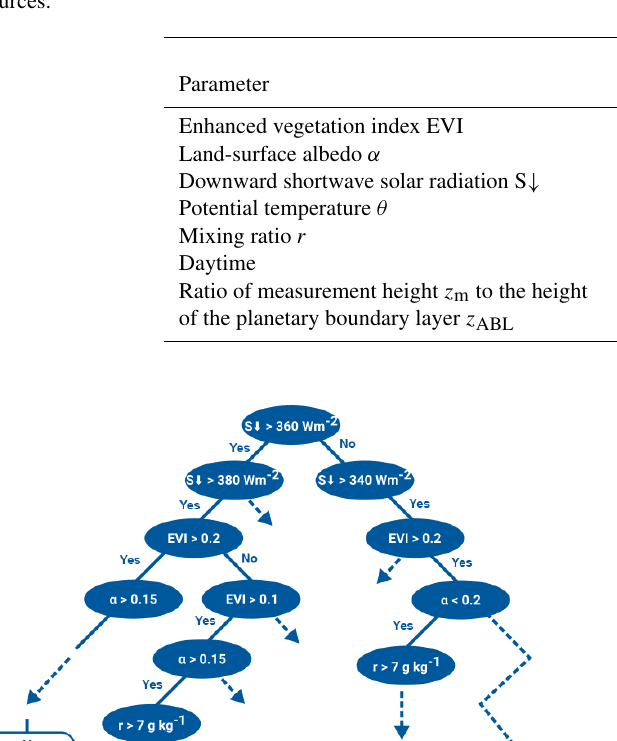
Table 3. Biophysical and meteorological drivers used for estimating environmental response functions, as well as the corresponding data sources.